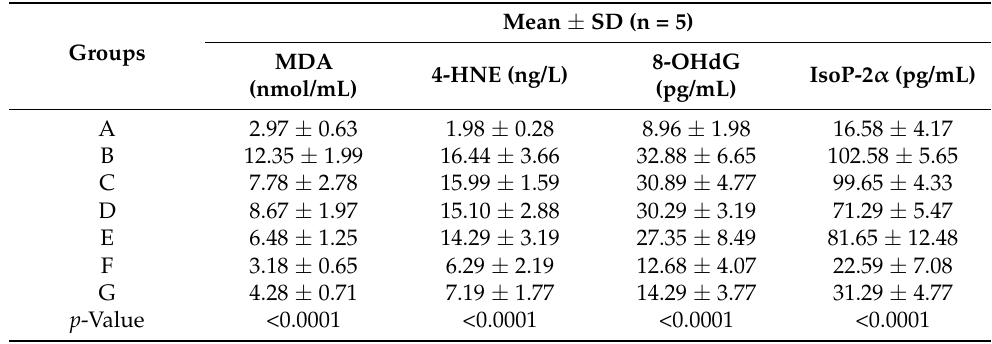
Table 4. DNA Damage Profile Of LPS Induced Multiple Sclerotic Wistar Rats.